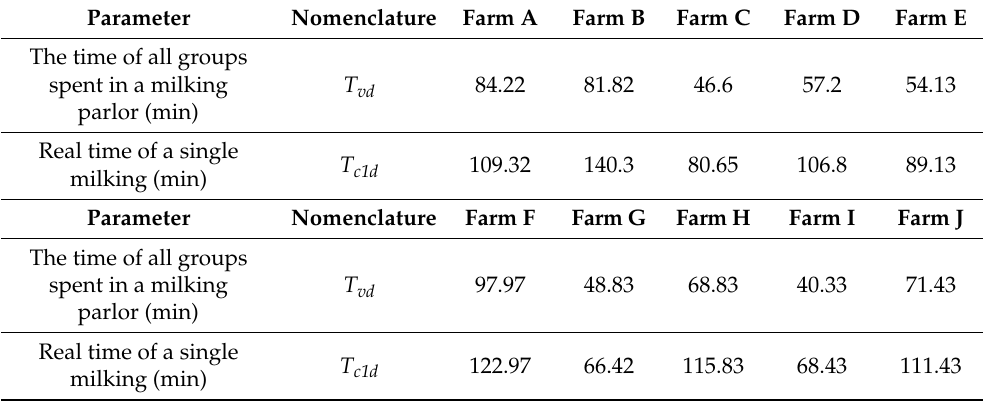
Table 3. The real time of all groups of goats spent in a milking parlor T vd (min) and total time of a single milking T c1d (min).